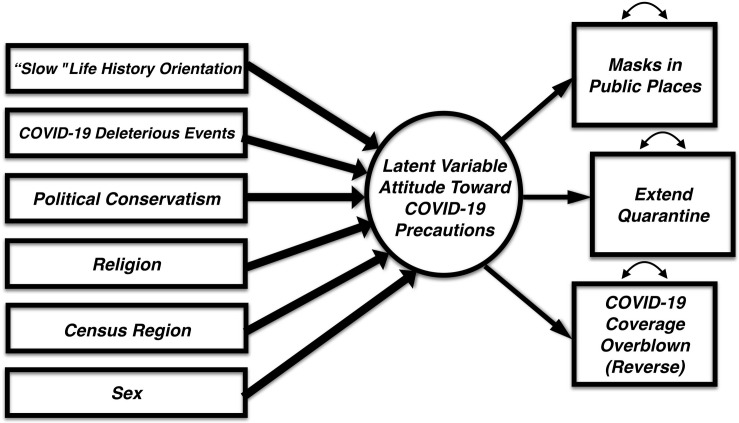
Proposed hybrid structural equation model including all model variables.